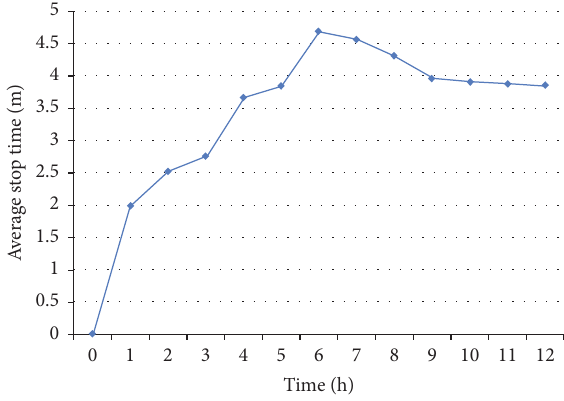
Figure 8: Average train delay time variation against time.